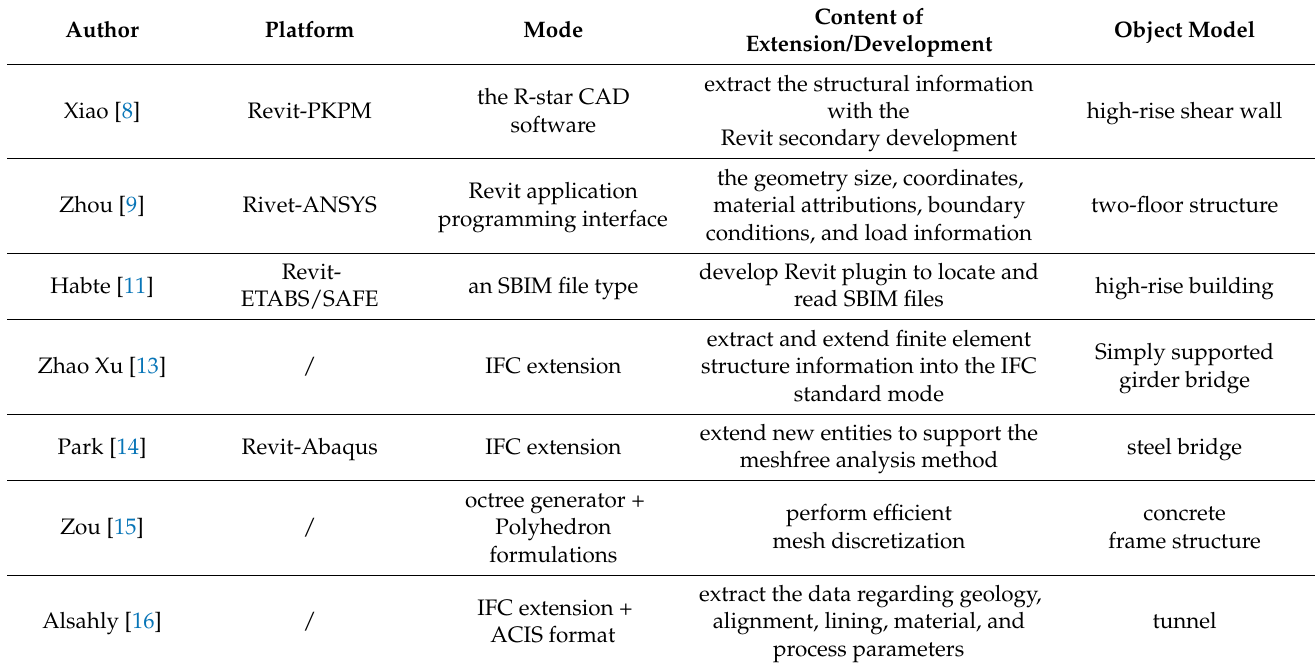
Table 1. Summary of data conversion and information transfer from BIM to finite element